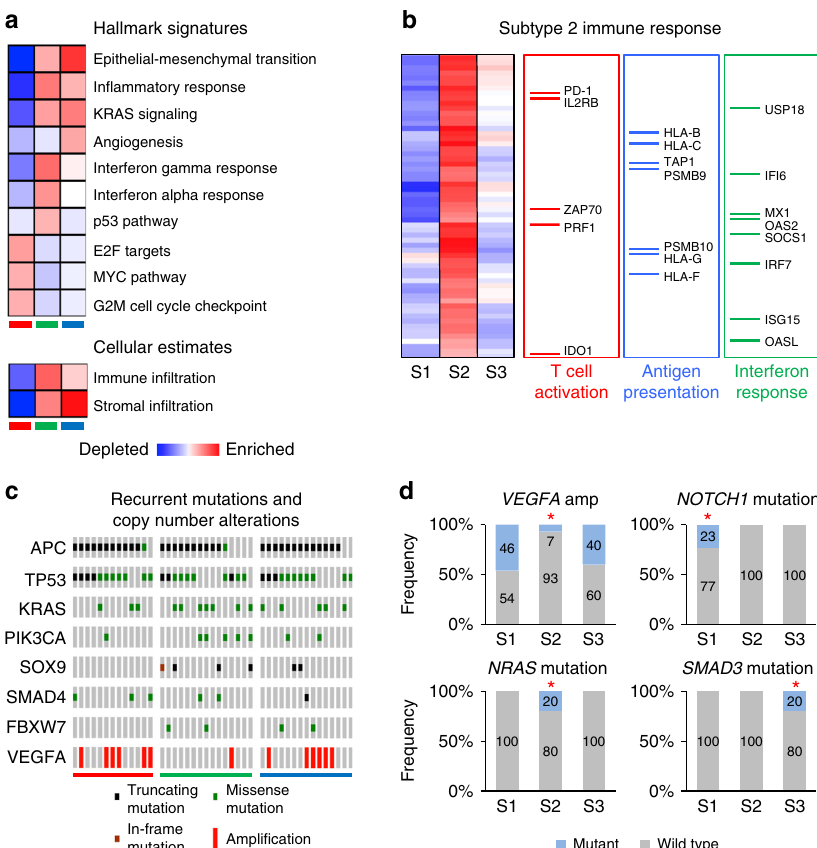
Fig. 3 Molecular signatures of intrinsic subtypes of colorectal liver metastases. a Ensemble of gene set enrichment analyses (EGSEA) of signi fi cantly enriched “ Hallmark ” and “ Cellular Estimate ” gene signatures within each molecular subtype. Red color denotes enrichment, while blue color indicates depletion. Color intensity in EGSEA heatmaps is proportional to signi fi cance level (see Supplementary Data 4 and 5). Subtype 1 = red, Subtype 2 = green, Subtype 3 = blue. b Functional categorization of differentially expressed immune genes overexpressed in subtype 2. In heatmap red color denotes overexpression, while blue color indicates suppression. c OncoPrint plot of recurrent colorectal cancer mutations and copy number alterations by subtype. d Frequencies of subtype-speci fi c genomic alterations. Asterisks denote statistical signi fi cance based on Fisher ’ s exact test comparing each subtype group to the two other subtypes. Subtype 1 = S1, Subtype 2 = S2, Subtype 3 =